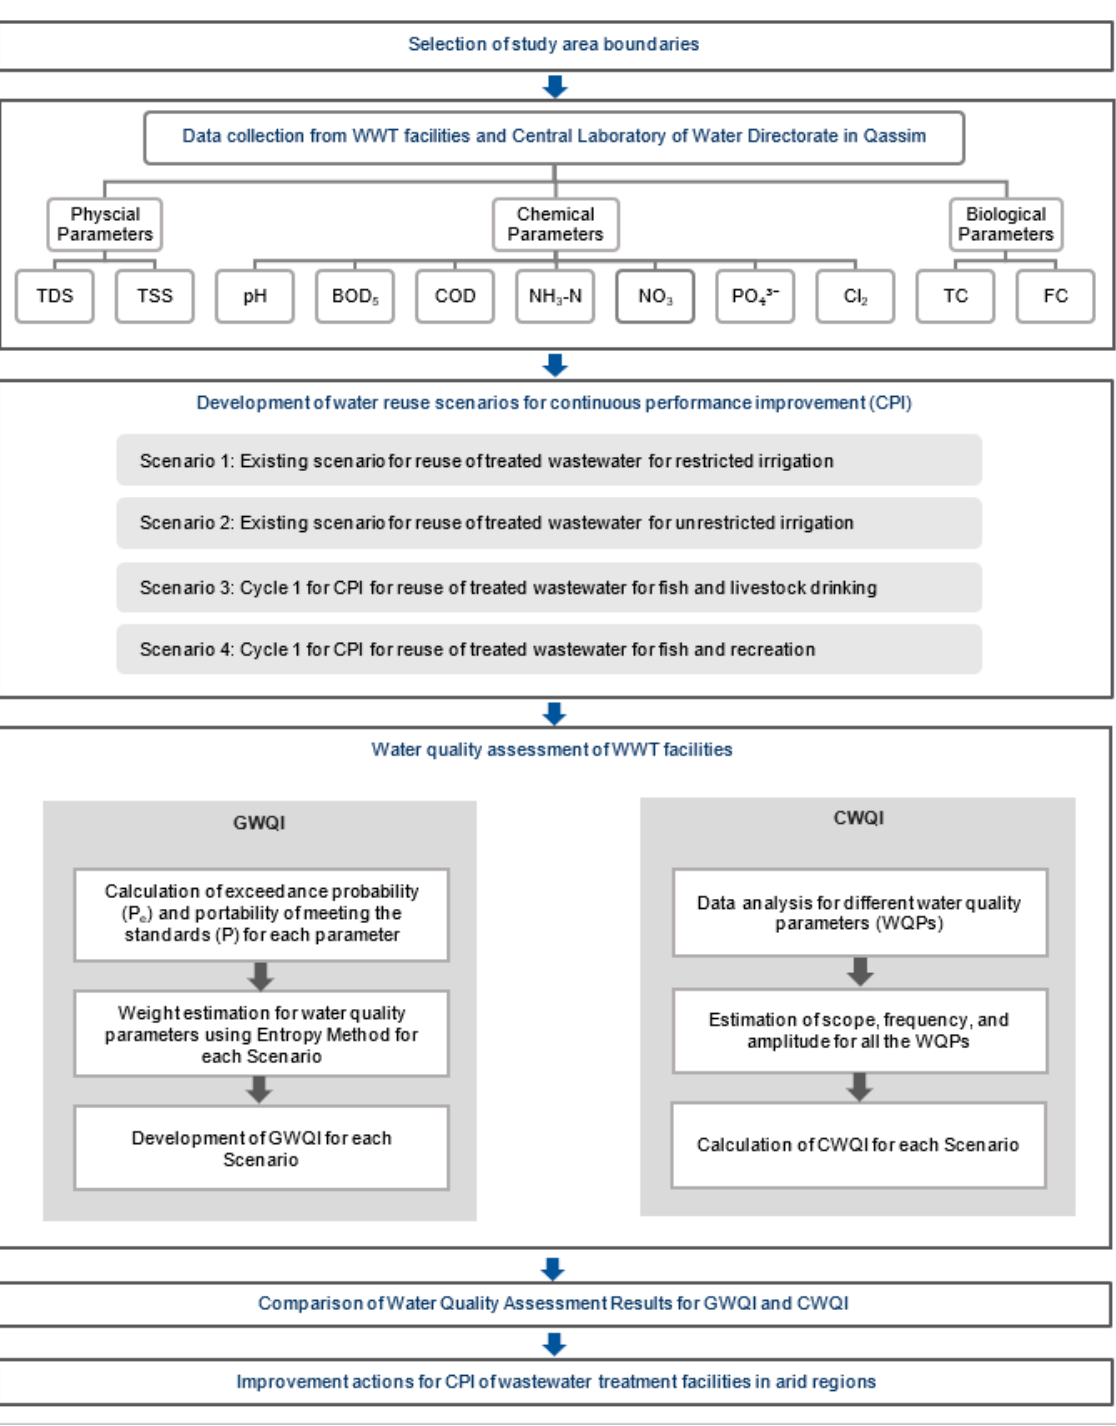
Figure 1. Continuous performance improvement framework for wastewater treatment facilities in arid regions.